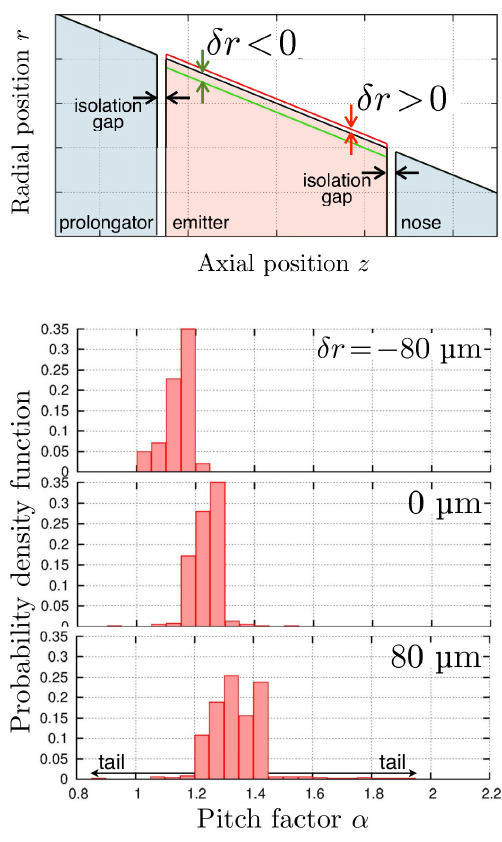
Figure 2. A small radial displacement of the emitter surface in relation to its neighboring parts (top) causes a significant varia- tion of the pitch factor distribution